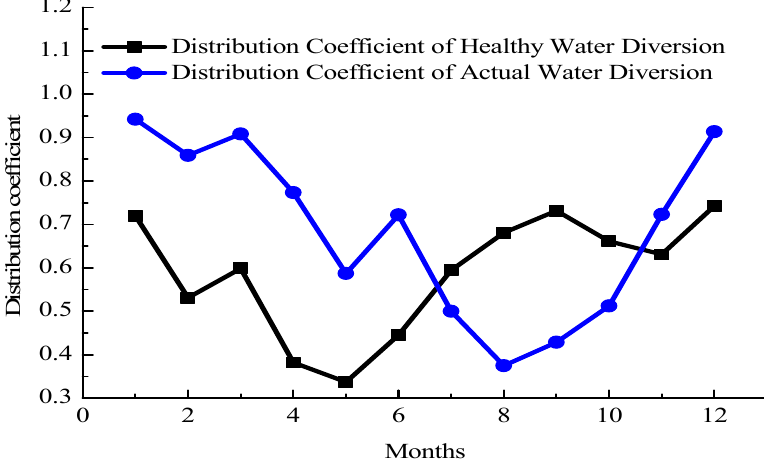
Figure 3. Comparison of distribution coefficient of the healthy water diversion and actual water diversion.